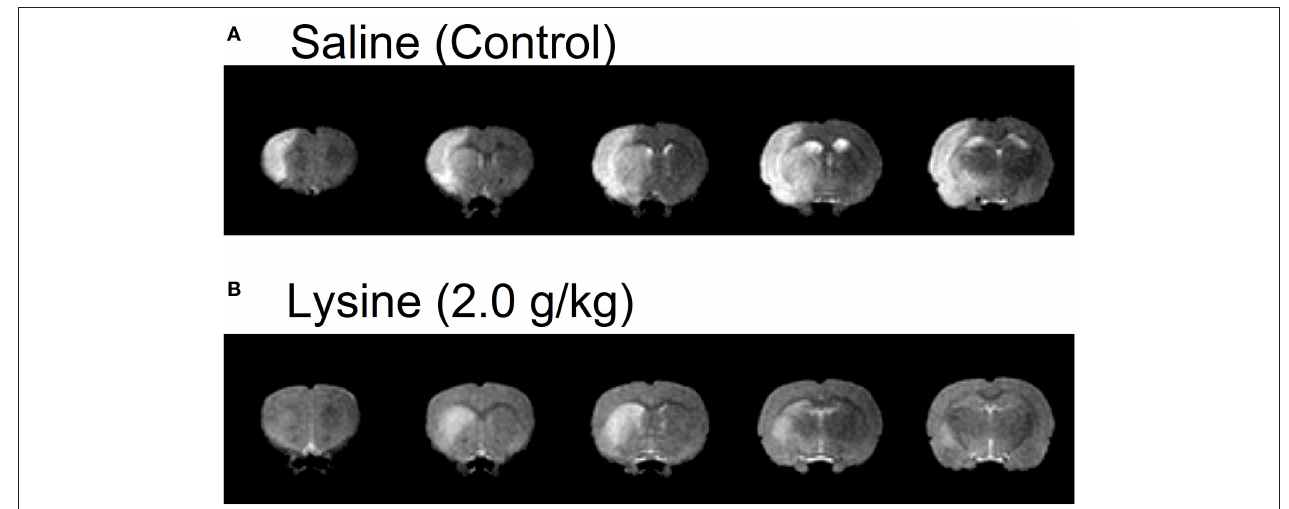
left hemispheres, which represent presence of edema. Note that oral administration of lysine (2.0 g/kg) suppressed cerebral edema, especially in the cerebral cortex. -weighted MrI. 2 Lysine also reduced hemispheric brain swelling. Slice thickness, 1.2 mm.